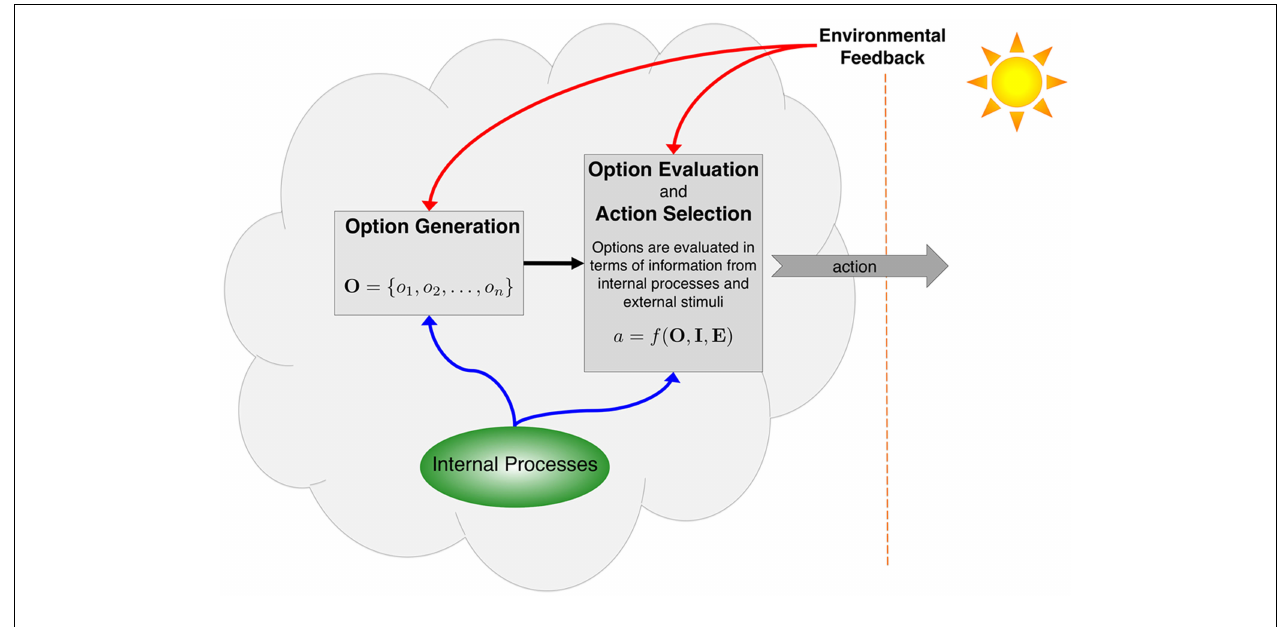
perceptual feedback from the environment.These internal and external processes also contribute to the initial generation of options, but the mechanisms for doing so are much less well understood than are those for